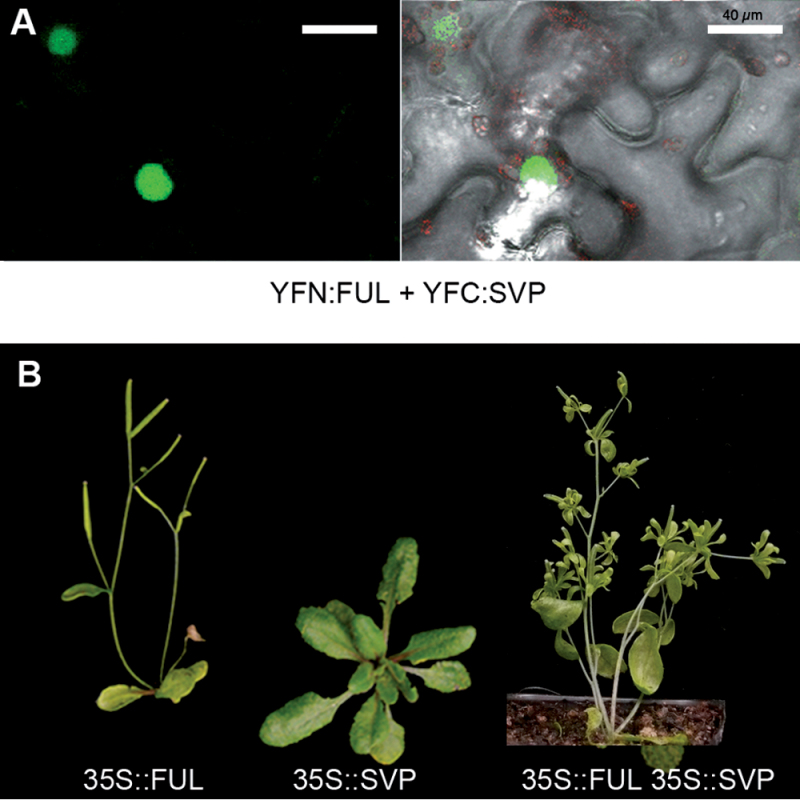
Interaction of FUL with SVP. (A) BiFC experiments in tobacco leaf cells between transiently expressed FUL and SOC1 fusions to the C- and N-terminal fragments of YFP, respectively. The left panel shows YFP reconstituted fluorescence (green) and the right panel is an overlay with a bright field image of the same sector where chlorophyll is shown in red. Negative controls for BiFC experiments are shown in Supplementary Fig. S3 at JXB online. Scale bars: 40 µm. (B) Phenotypes of the 35S::FUL, 35S::SVP, and 35S::FUL 35S::SVP double over-expression lines. FUL over-expression reverts the late flowering phenotype of 35S::SVP, although inflorescence development is partially restored respect to the 35S::FUL plants.